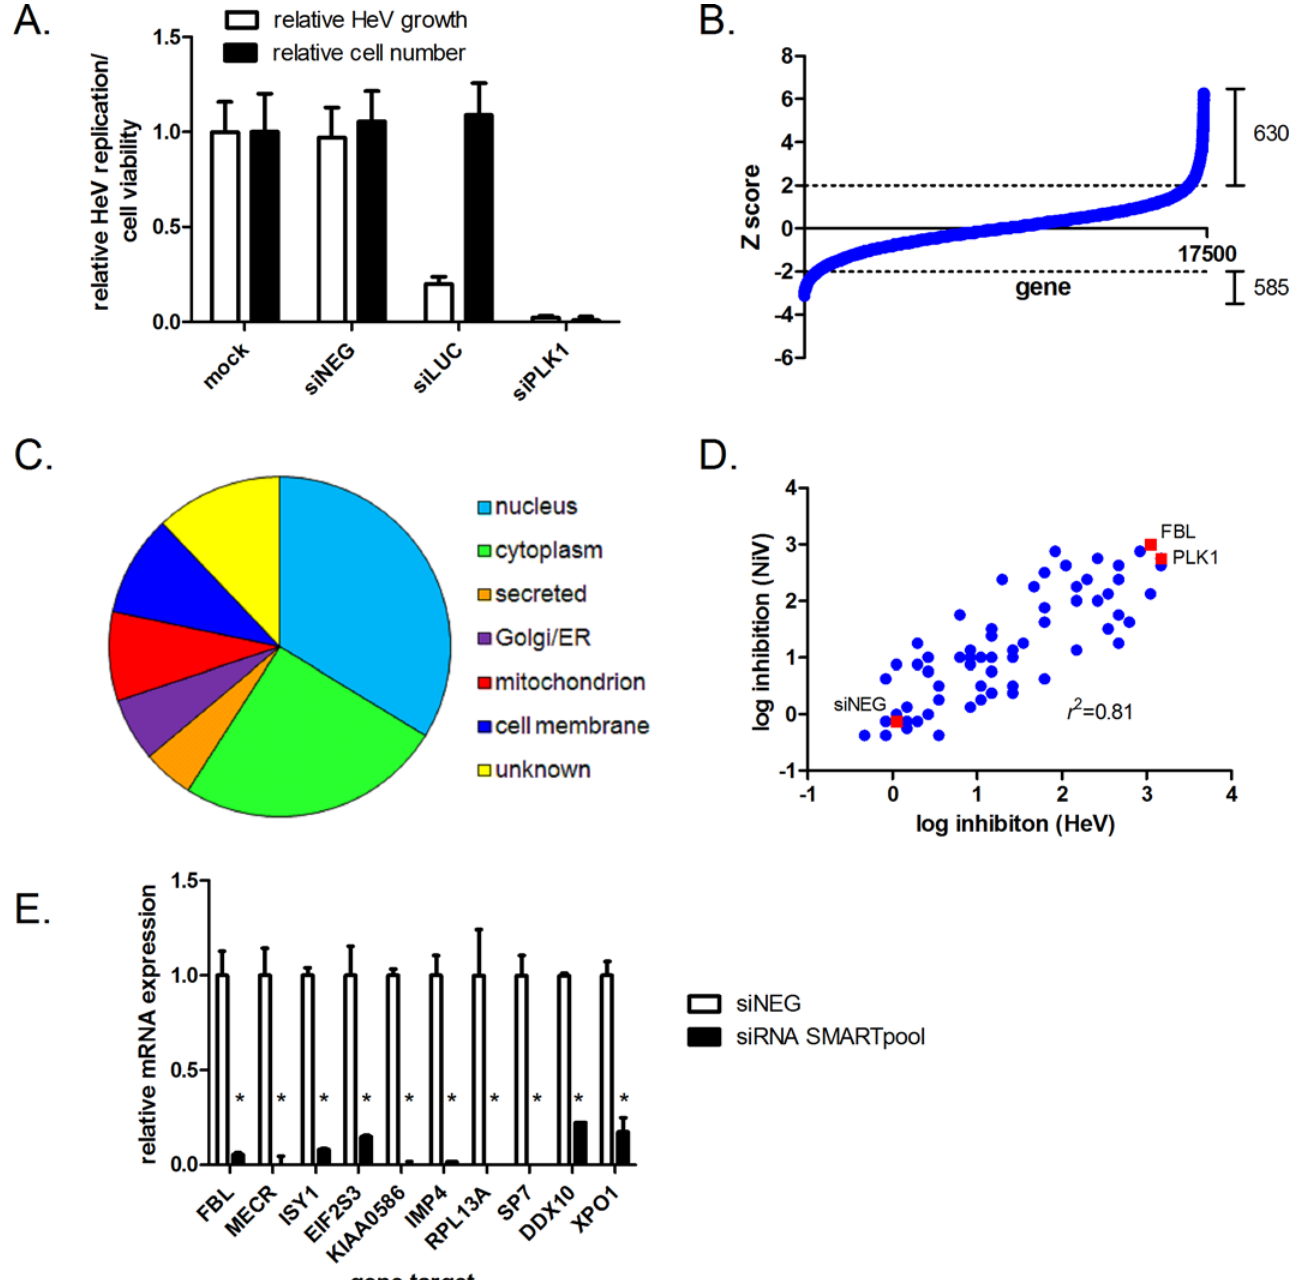
Fig 1. Genome-wide siRNA screen of host genes required for HeV replication. (A) Negative (siNEG), positive (siLUC) and death (siPLK1) control siRNAs used in this study, showing their impact on HeLa cell numbers and growth of recombinant HeV (B) Results from the genome-wide siRNA screen, with genes ranked using a Z score approach, from lowest (decreased virus replication) to highest (increased virus replication). The dotted horizontal lines represent the threshold of statistical significance (Z (cid:1) 2 or (cid:3) -2). (C) Sub-cellular localization of the 66 high- and medium confidence genes. Genes were manually curated on the basis of subcellular localization annotated in Uni-Prot and GO. (D) Decreases in wild-type HeV and NiV titres during infection (MOI 0.1 for 48 h) caused by silencing of 66 medium- and high-confidence genes. Full details of virus titres are shown in S4 Table. (E) mRNA levels of 10 selected host genes, 72 h post-siRNA transfection. The level of knockdown was normalised to the level of endogenous expression in siNEG transfected cells, set to 1. * p < 0.05.